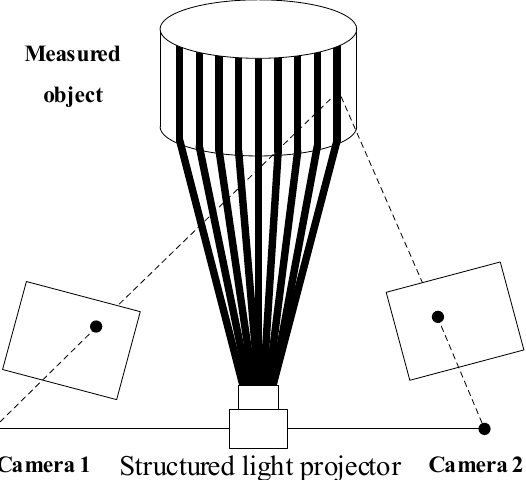
Figure 3. Schematic diagram of mechanism of stripe-area laser scanning system.